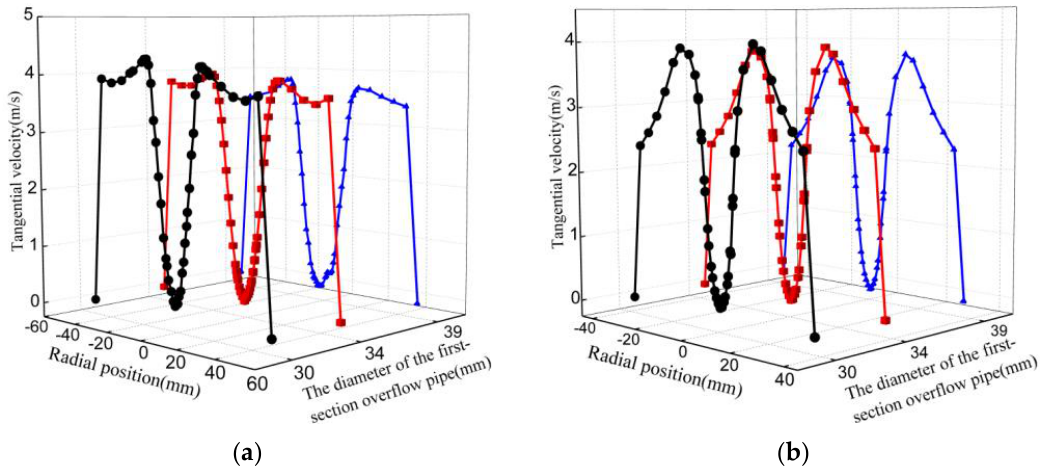
Figure 7. Effect of the first-section overflow pipe diameter on tangential velocity: ( a ) Cross-section of Z 1 ; ( b ) Cross-section of Z 2.